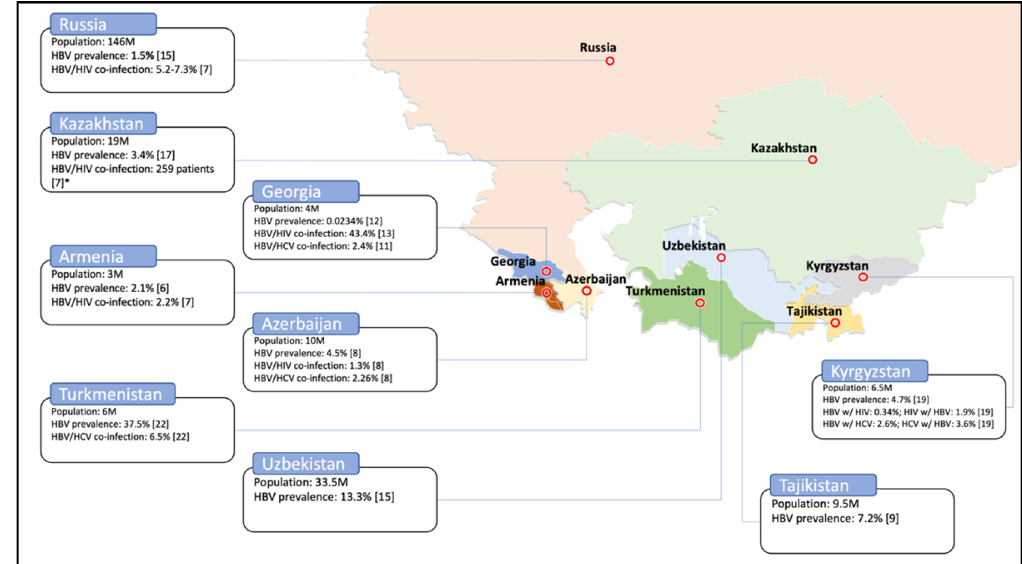
Figure 1. Prevalence of hepatitis B virus (HBV) and co-infections of HBV/HIV and HBV/HCV. Total population for each country [4] is mentioned along with the prevalence of single and double infections, wherever available. The map template was taken from the source [5].